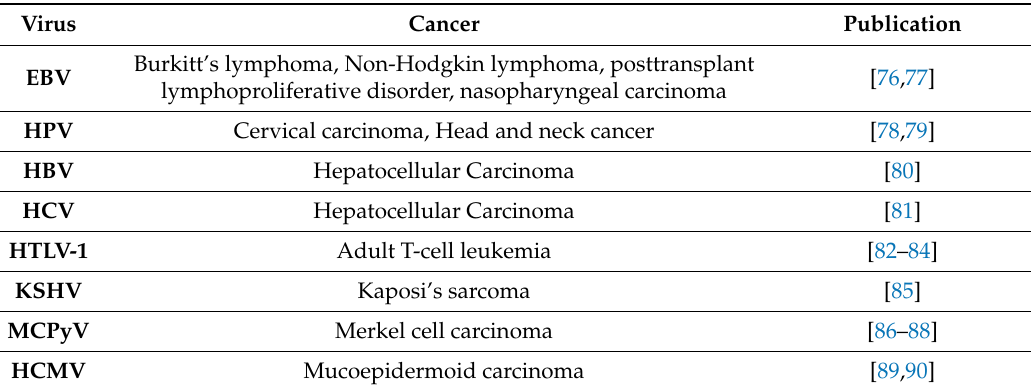
Table 1. Oncoviruses and respective